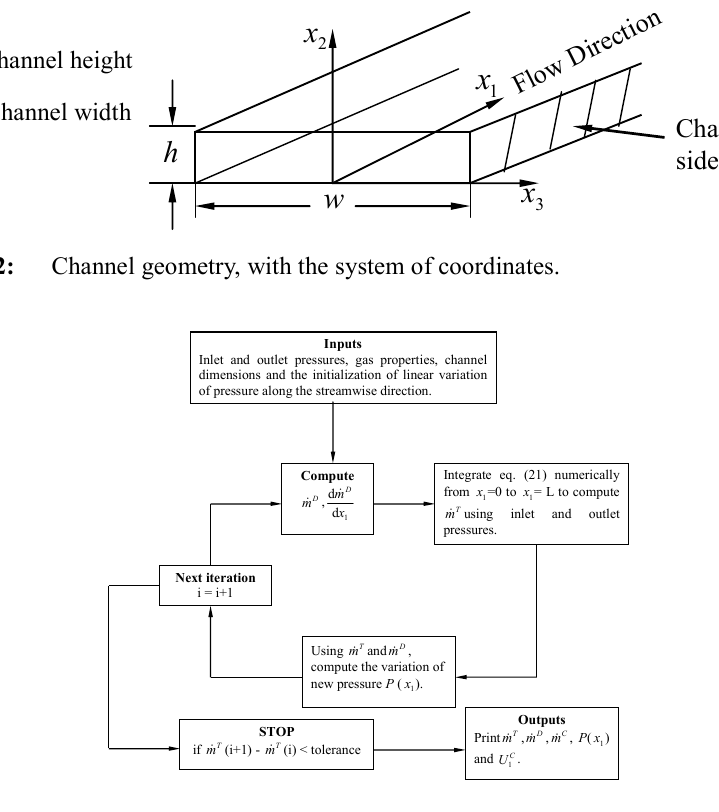
Fig. 3: Program flow chart showing the solution procedure to solve Eq.